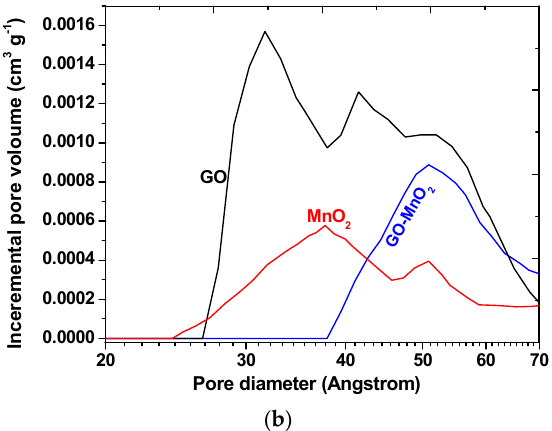
Figure 3. ( a ) N 2 adsorption isotherms for GO (black line), MnO 2 (red line) and GO ‐ MnO 2 ; (blue line); ( b ) pore size distribution for GO, MnO 2, and GO ‐ MnO 2 . Table 1. Textural parameters of GO, MnO 2, and GO ‐ MnO 2.